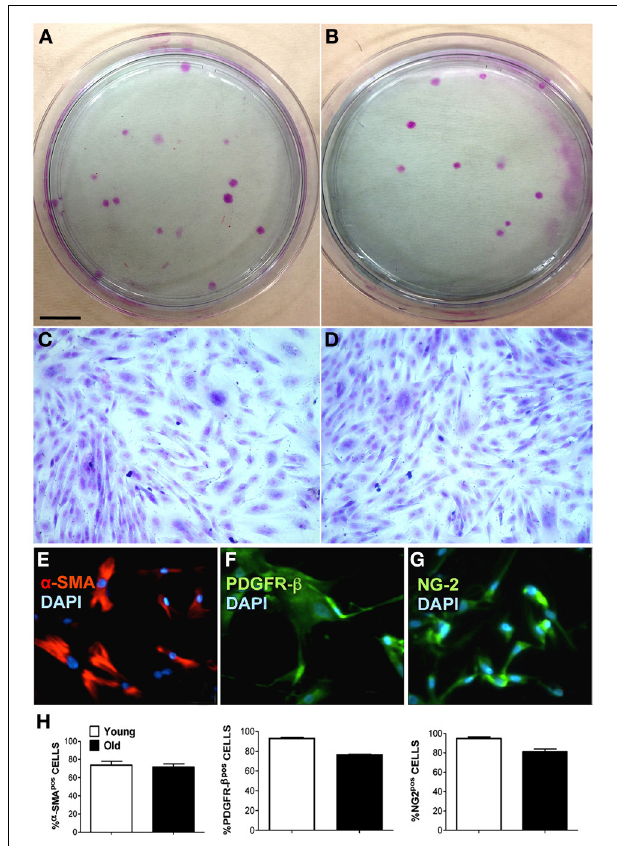
FIGURE 1 | Characterization of muscle-derived pericytes (MP) from swine. MP were analyzed for their behavior and their expression of characteristic pericyte markers to define their cellular identity. (A,B) Young (A) and old (B) swine-derived MP showing fibroblast colony-forming units (CFU-F) when seeded at low confluence. Giemsa staining on plastic 9cm Petri dishes. (C,D) Single CFU-F morphology of young (C) and adult (D) MP, presenting identical spindle-like morphology. (E–G ) Representative immunofluorescence staining of young MP showing positivity (pos) for alpha-smooth muscle actin ( α -SMA) (E) , chondroitin sulfate proteoglycan (NG-2) (G) , and platelet-derived growth factor receptor beta (PDGFR- β ) (F) . Nuclei were counterstained with 4, 6-diamidino-2-phenylindole (DAPI). (H) Average data scored from immunofluorescence in (E–G) . Scale bar: (A,B) 1cm; (C–G) 15 μ